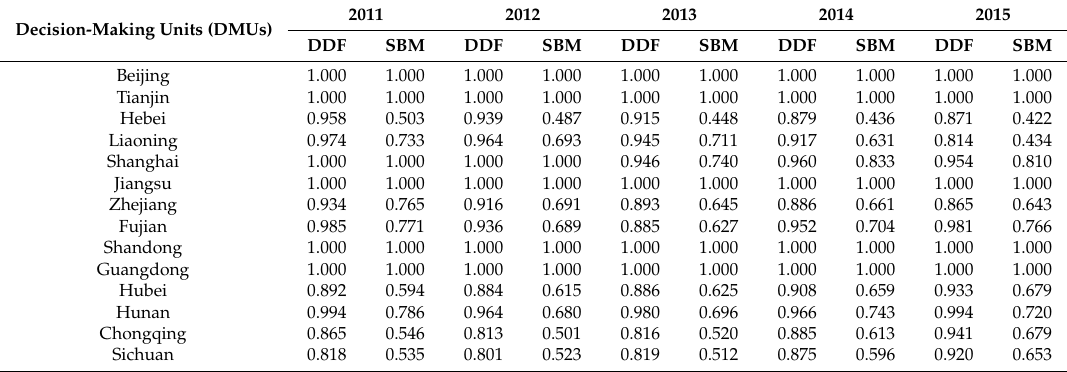
Table 2. Measured by Directional Distance Function (DDF) and Slacks Based Measure (SBM) from